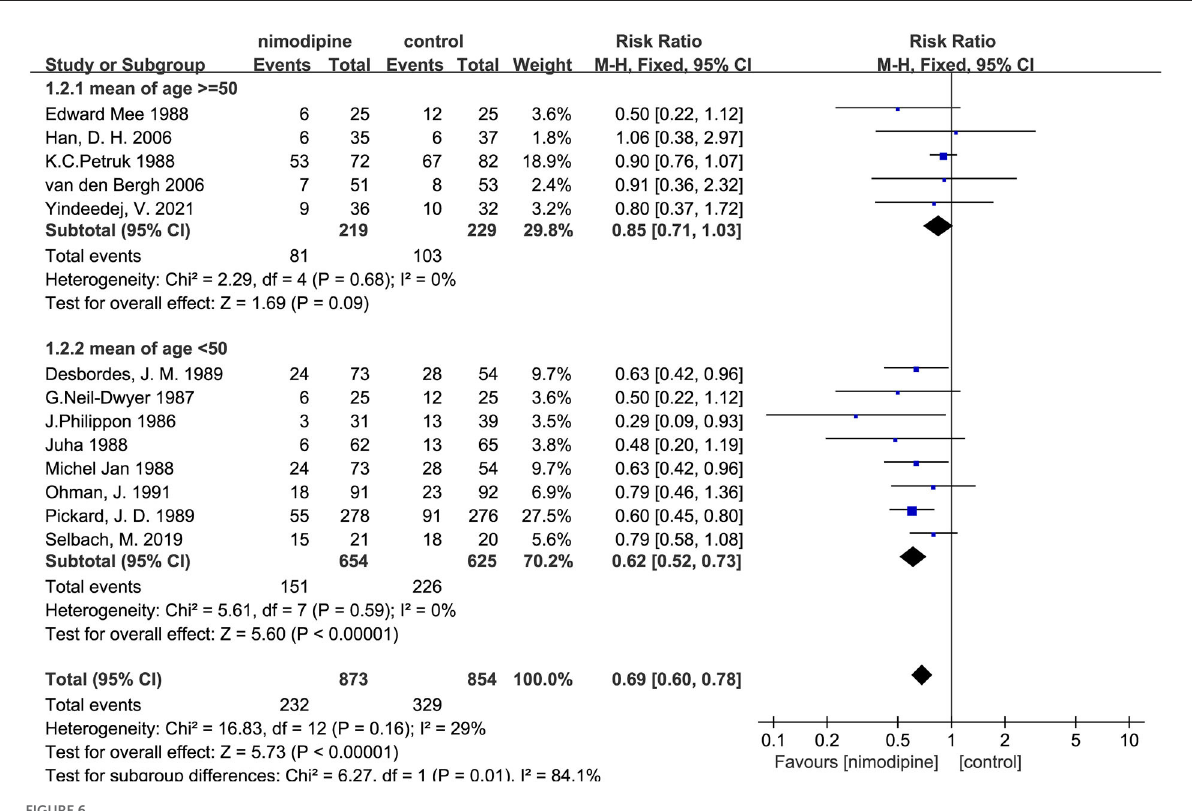
FIGURE6 Subgroup analysis of poor outcome according to the mean age.